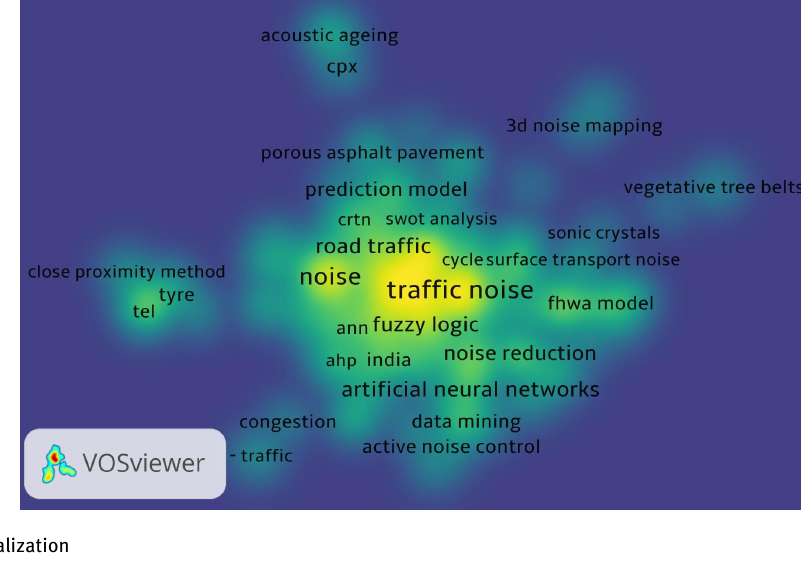
Figure 3: Density visualization